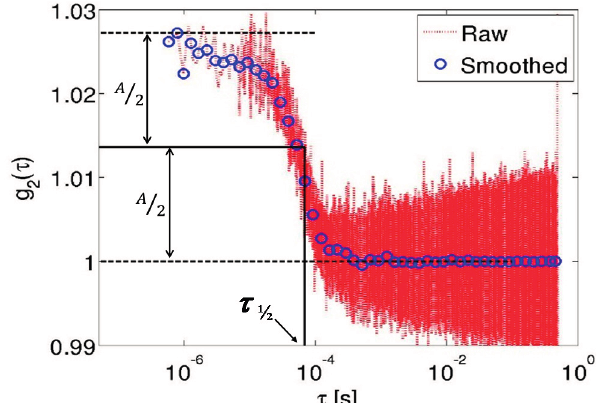
Figure 1. The autocorrelation curve g 2 ( τ ) for a representative flow-channel experiment calculated numerically using the Fourier transform (dotted line) from the data acquired using the Raspberry Pi and its down-sampling to logarithmically, uniformly spaced points (blue circles). The amplitude, A , of g 2 ( τ ), as well as the value of τ ½ , are also